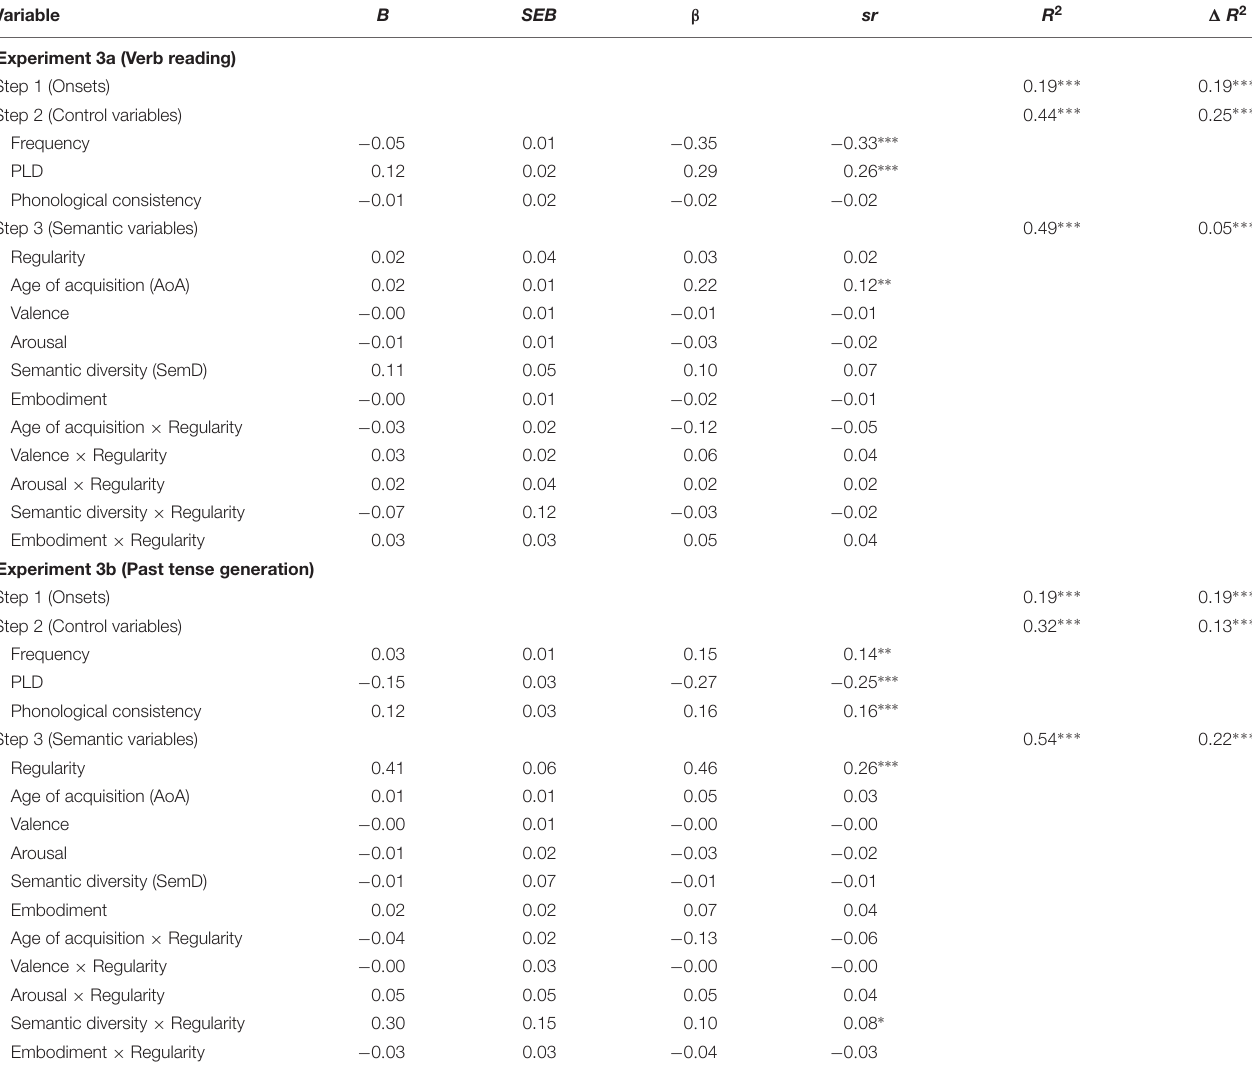
TABLE 5 | Regression coefficients from item-level regression analyses for standardized reading and past tense generation latencies, Experiments 3a and 3b.